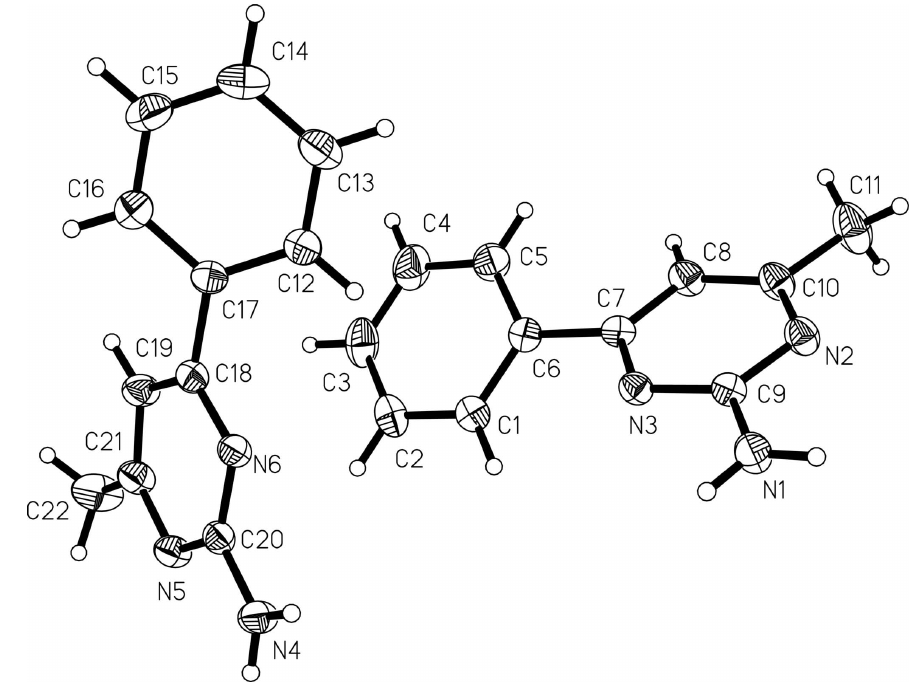
Figure 1 The molecular structure and atom-labeling scheme for (I), with displacement ellipsoids drawn at the 30% probability